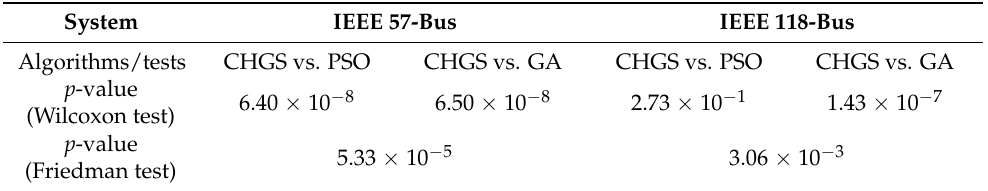
Table 7. p -values obtained with Wilcoxon’s and Friedman’s rank-sum